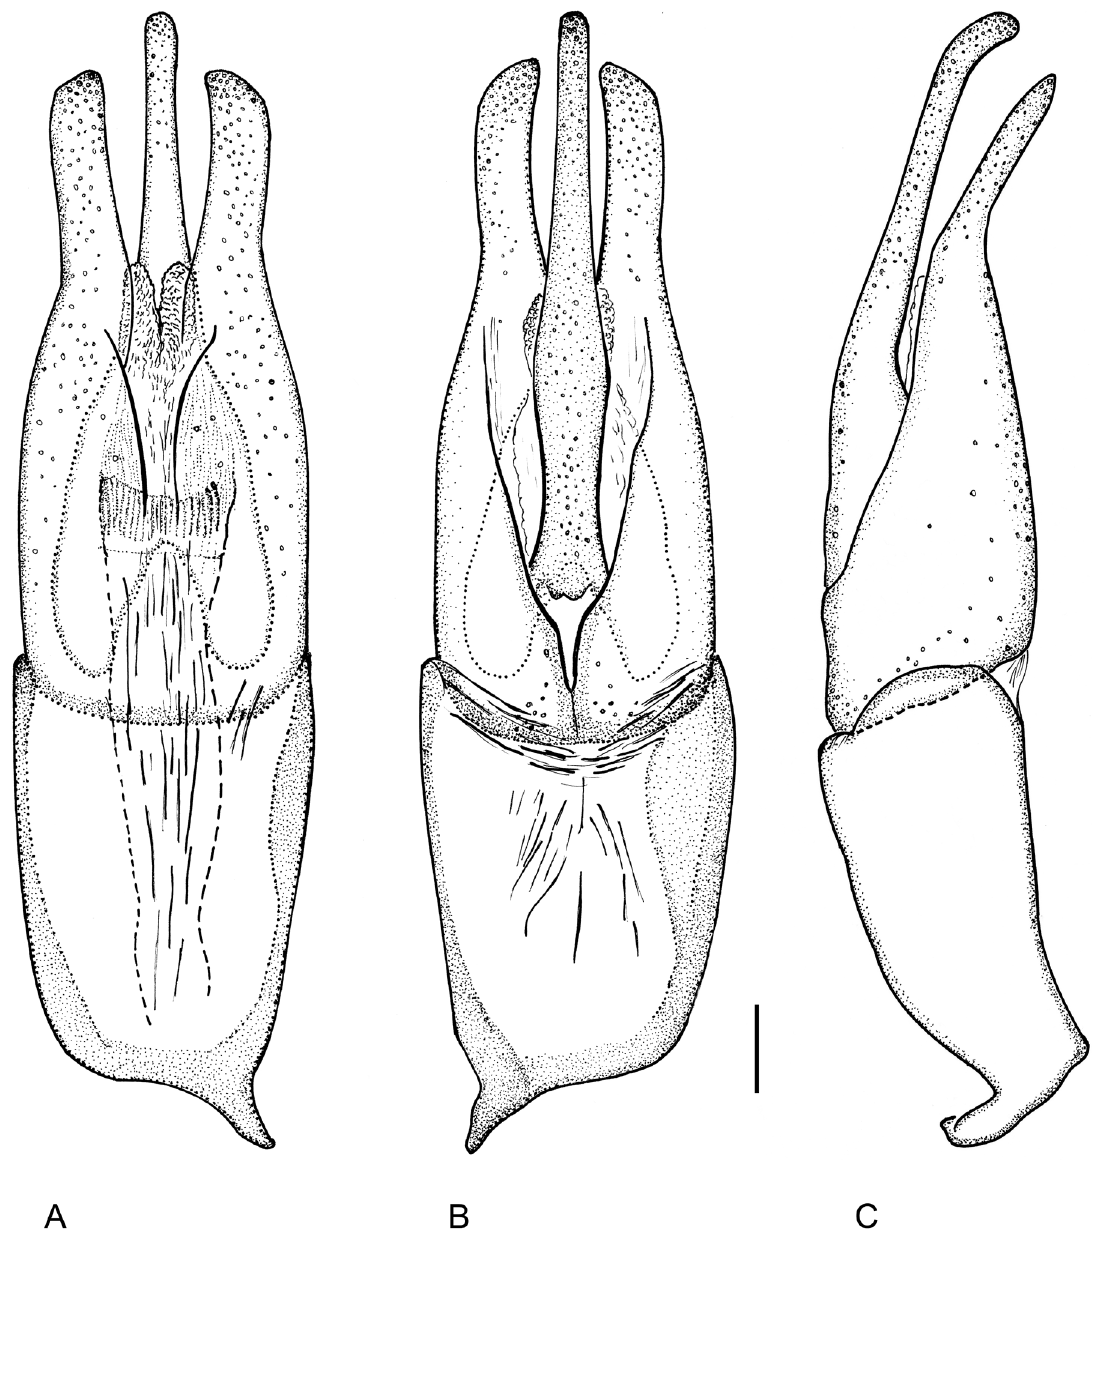
Fig. 3. Potamophilus kelabitensis sp. nov., aedeagus of holotype (CFDS). A . Ventral aspect. B . Dorsal aspect. C . Lateral aspect. Scale bar = 0.1